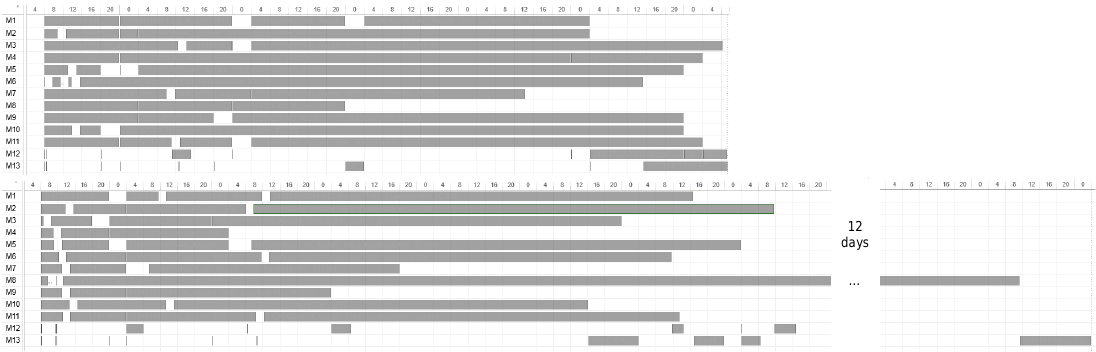
Figure 15. Comparison of schedules in MS Project for quantile 91% ( above ) and quantile 92% ( below ) in calendar week 13 with tabu search